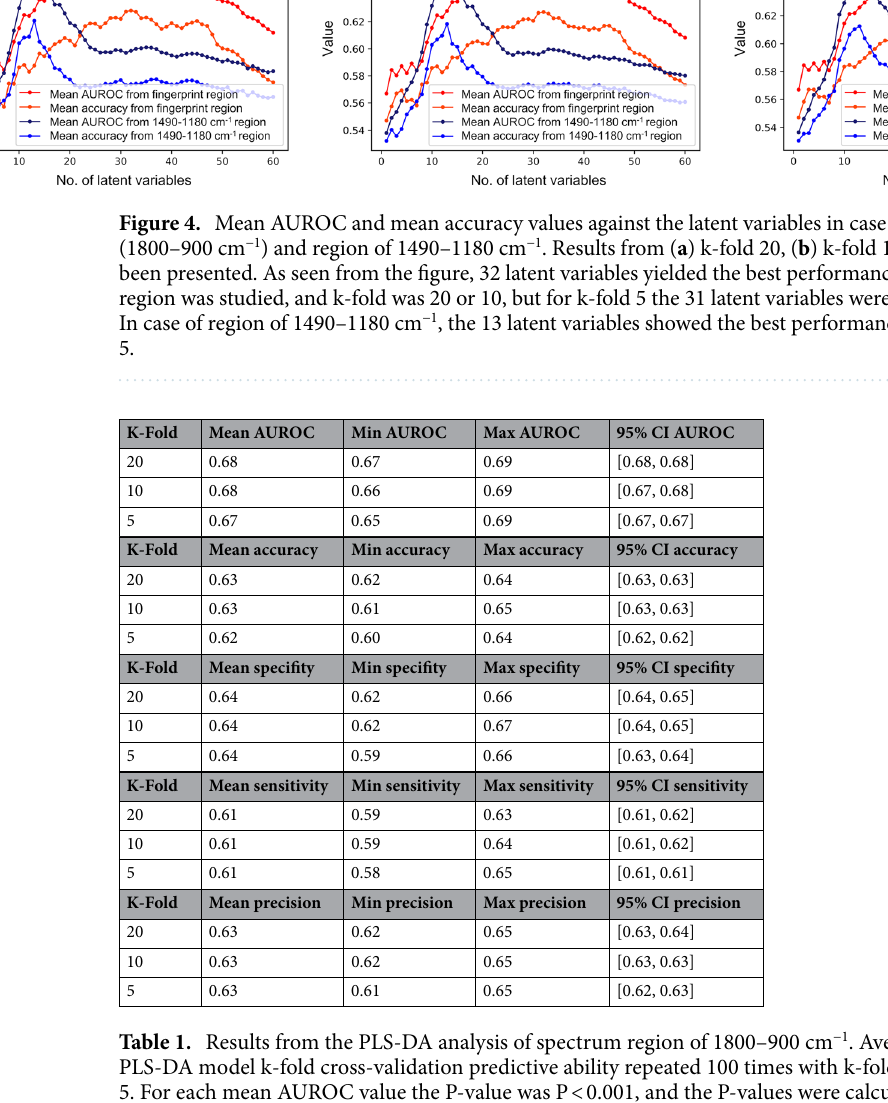
mean AUROC value obtained from the same study repeated with the randomly permuted sample labels (for each P-value, P < 0.001). Averaged ROC curves were also calculated (Fig. 5). When the mean accuracies, the mean specificities, the mean sensitivities, and the mean precisions were cal- culated, a global threshold of 0.5 was set to divide the PLS-DA analyzed samples into the positive and negative classes, also resulting the mean confusion matrixes shown in Fig. 5. The mean accuracies of 0.63, 0.63, 0.62, and the mean specificities of 0.64, 0.64 and 0.64 for k-folds 20, 10 and 5, respectively were achieved (Table 1). The mean sensitivities of 0.61, 0.61, 0.61, and the mean precisions of 0.63, 0.63 and 0.63 were obtained for k-folds 20, 10 and 5, respectively (Table 1). The spectral region of 1490–1180 cm −1 (Fig. 3) from fingerprint region yielded results close to, or almost the same compared to the fingerprint region when the 13 latent variables were set for the PLS-DA model (Fig. 4).